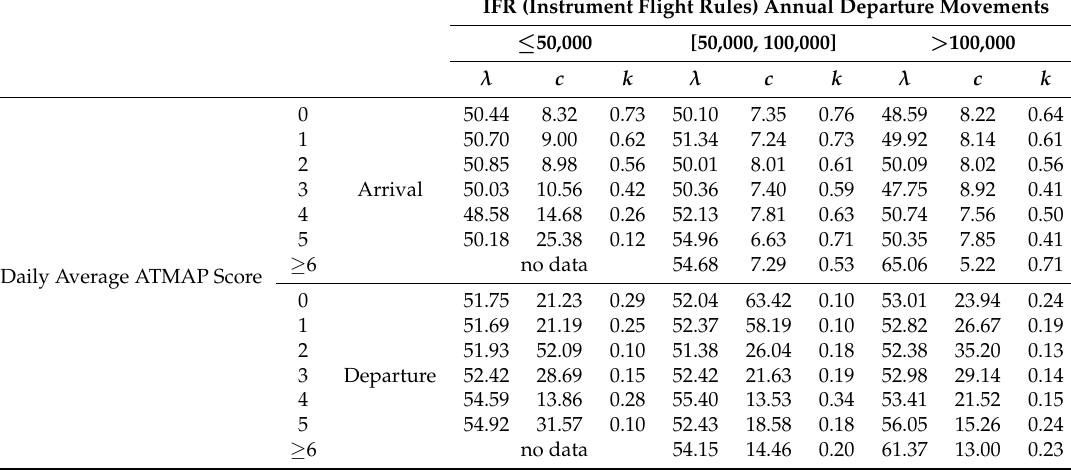
Table 6. Parameters set for the Burr